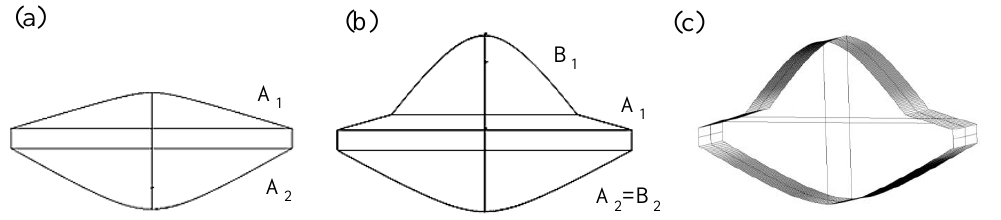
+ A ); ( c ) Cylindrical hybrid lens with 1 2